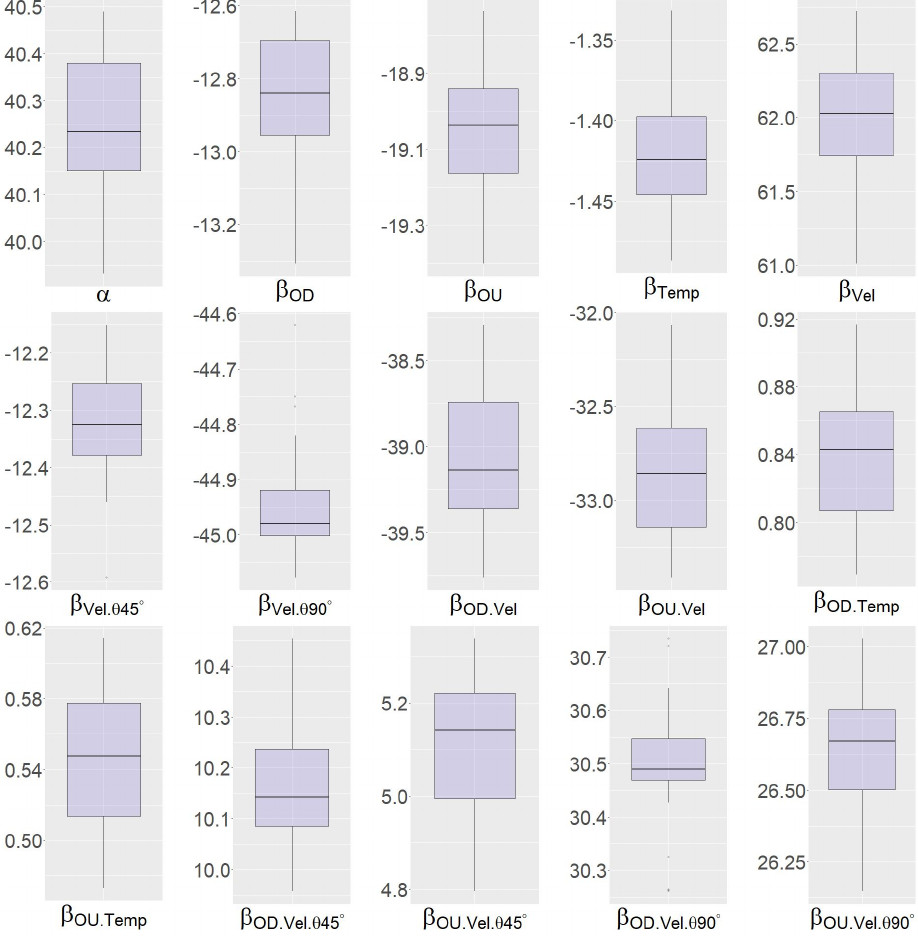
Figure 8. Coefficients distribution based on 20 test for the “all”